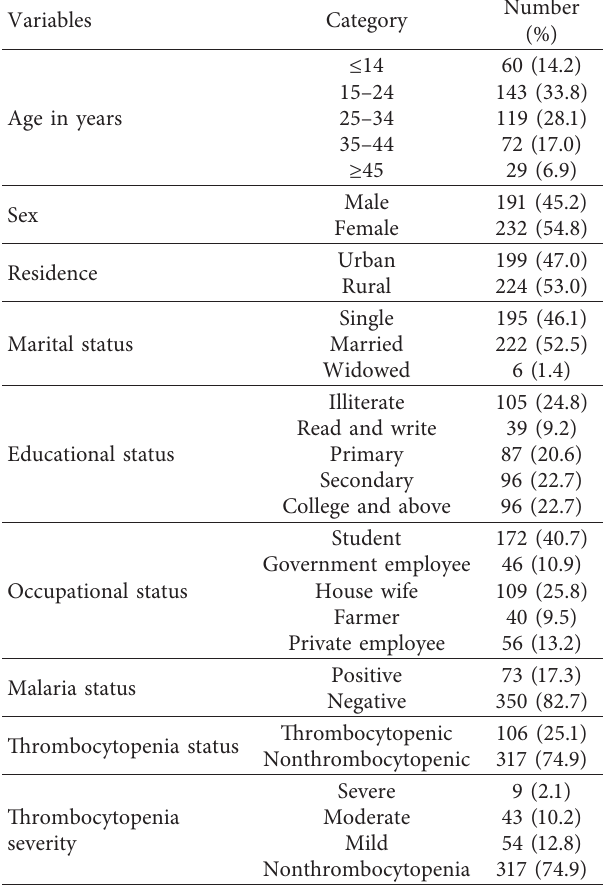
Table 1: Sociodemographic and clinical characteristics of study participants ( n �